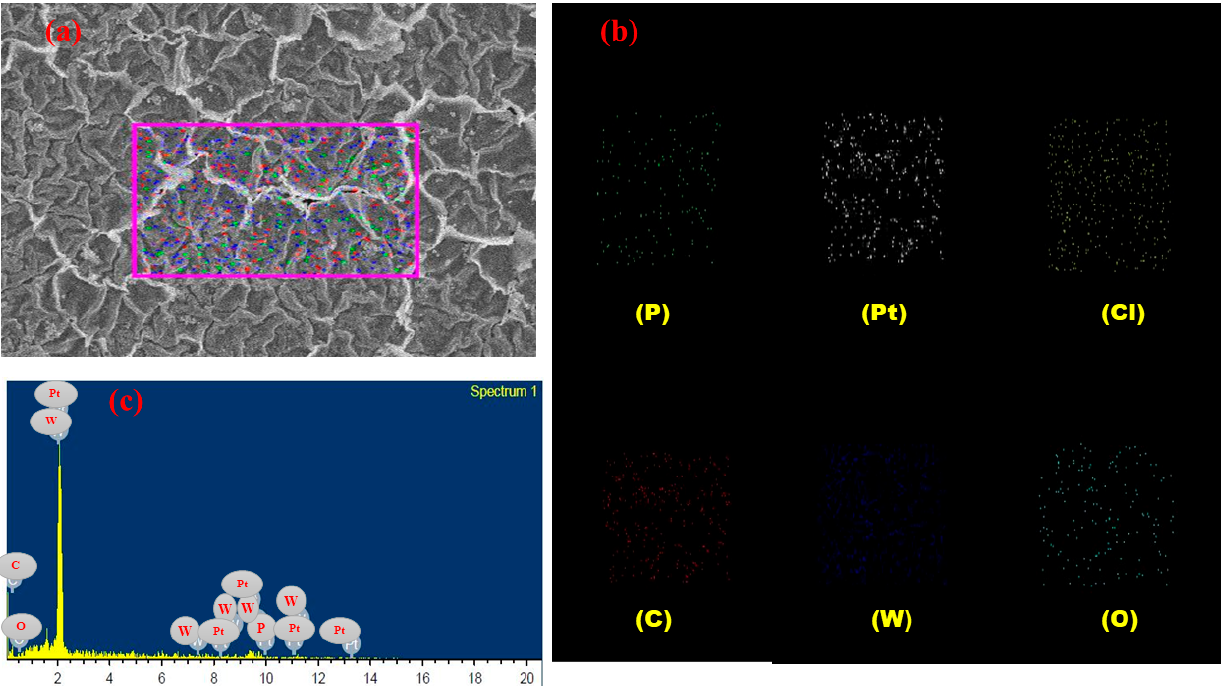
Figure 10. SEM images of the SPVC–PTA–Pt IPMC membrane.